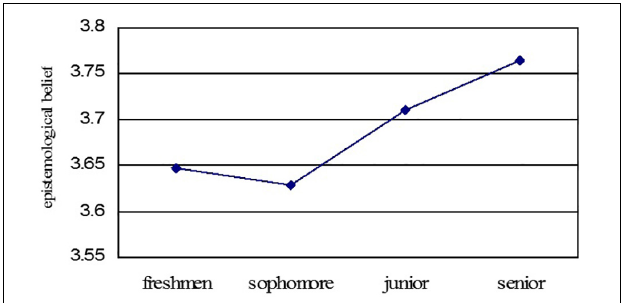
FIGURE 2 | The general development trend of college students’ epistemological beliefs.